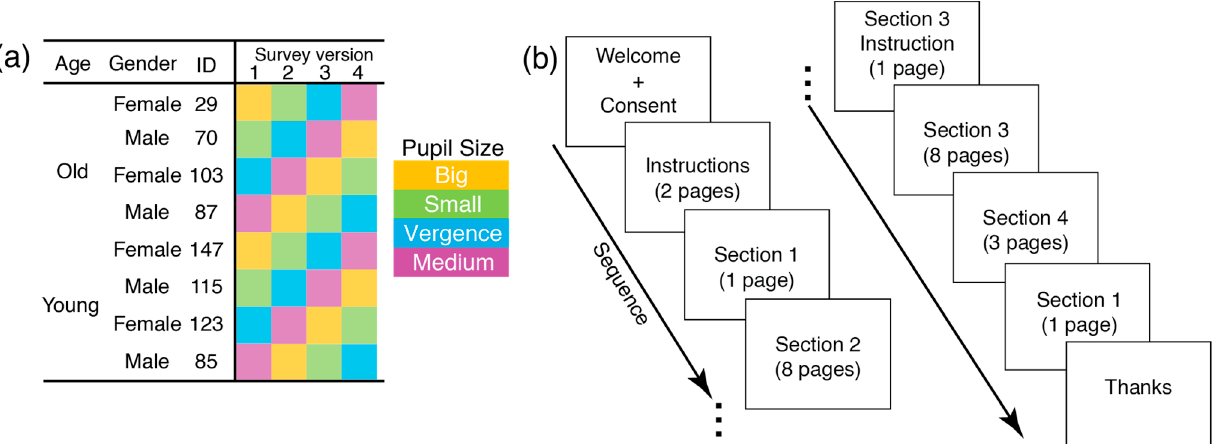
Figure 2. Survey version and sequence for both experiments. ( a ) illustrates the survey versions based on the Latin-square for presenting the stimuli. There were eight eye models. The age, gender, and ID of the models were counterbalanced. Each eye model never appeared more than once within a survey version. The colors correspond to various pupils. ( b ) shows the survey sequence. All participants completed the same sequence.